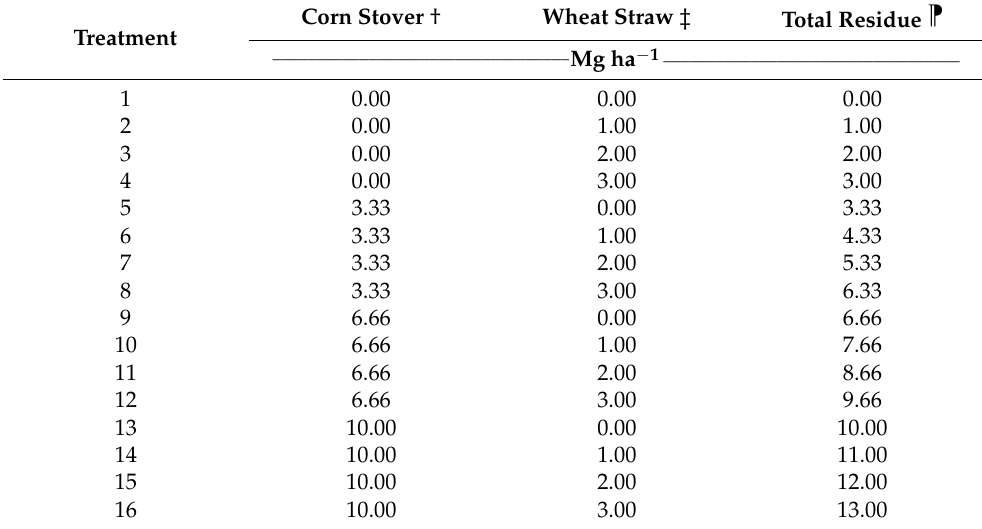
Table 2. Residue sources and application rates for residue management field-based experiments NK1 and NK2 in a corn-wheat/soybean rotation in New Kent, VA.